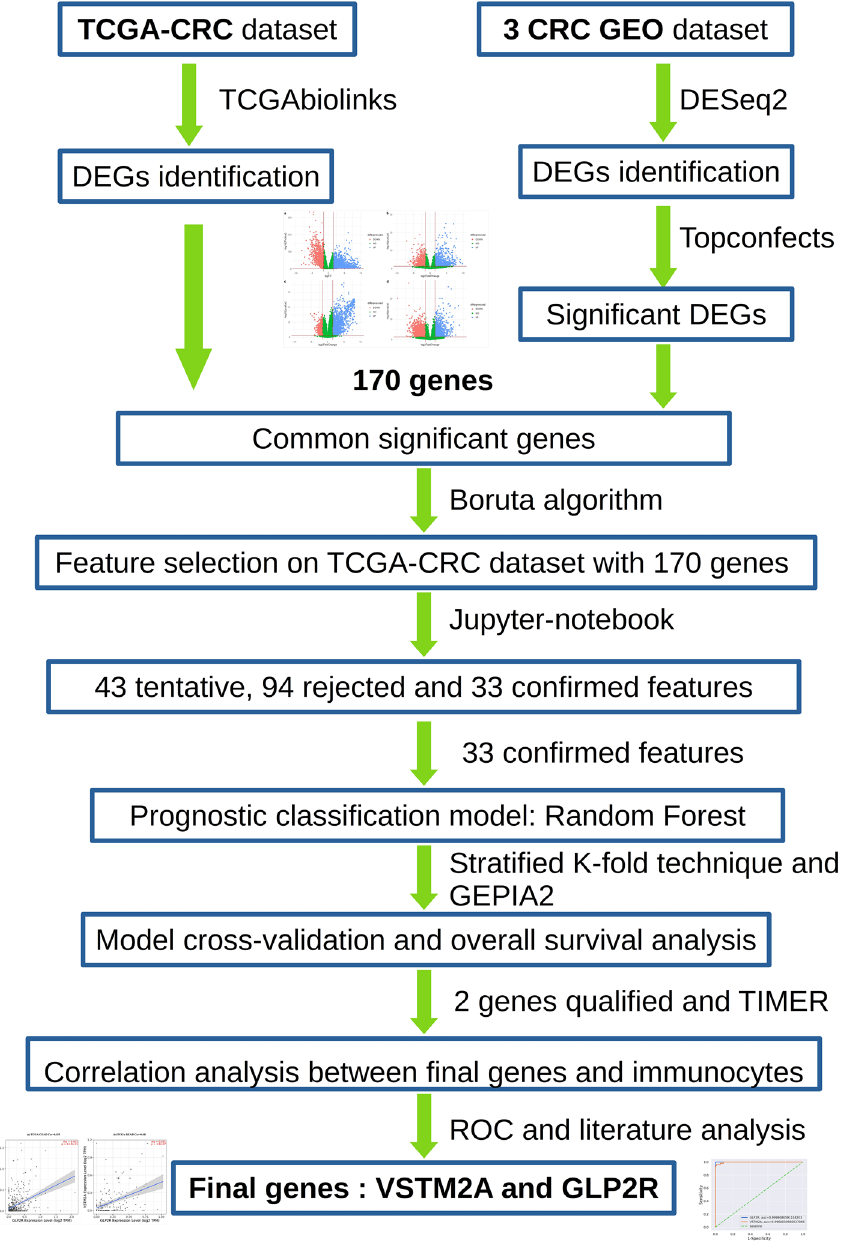
Figure 1. Workflow for identifying gene signatures for colorectal cancer. TCGA The Cancer Genome Atlas, CRC colorectal cancer, GEO gene expression omnibus, DEGs differentially expressed genes, DAVID database for annotation, visualization, and integrated discovery, GEPIA gene expression profiling interactive analysis.